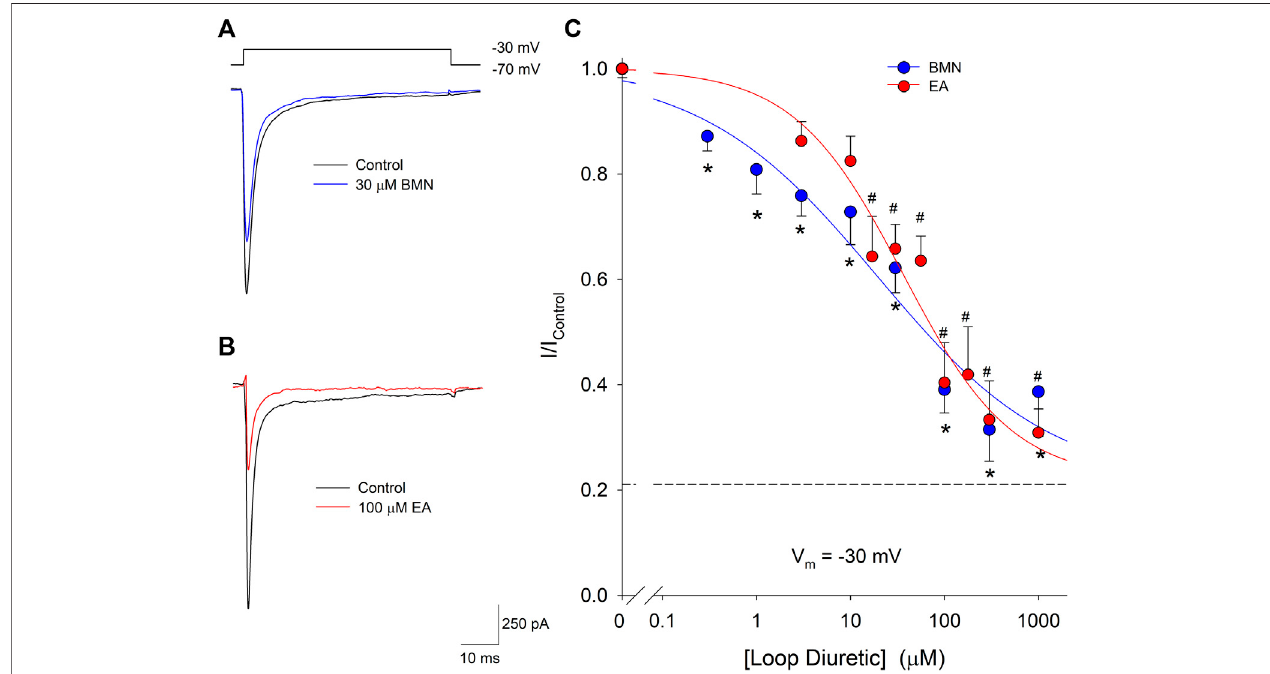
FIGURE 6 | Bumetanide and ethacrynic acid inhibit voltage-gated sodium channels in a dose-dependent manner. (A) , Representative traces of whole-cell VGSC currentsrecordedfromasingleneuroninresponseto50msecstepsfromaholdingpotentialof − 70 mVto − 30 mVintheabsence(Control,blacktrace)andpresenceof 30 μ MBumetanide(30 μ MBMN,bluetrace). (B) ,Representativetracesofwhole-cellVGSCcurrentsrecordedfromasingleneuroninresponseto50 msecstepsfroma holding potential of − 70 mV to − 30 mV in the absence (Control, black trace) and presence of 100 μ M ethacrynic acid (100 μ M EA, red trace). (C) , Concentration- response relationship of relative peak inward VGSC currents (mean ± SEM) elicited by voltage steps from − 70 to − 30 mV. Currents were normalized to control peak currentsmeasuredintheabsenceofbumetanideorethacrynicacid.Datapoints(bumetanidebluecircles;ethacrynicacidredcircles)werebest fi t(bumetanideblueline, ethacrynicacidredline)toasingle-siteLangmuir-Hillequationwithanasymptoticminimum(dashedline). n > 15forallbumetanidedatapointsandn > 6forallethacrynic acid data points. Asterisks and pound symbols denote signi fi cant difference from Control for BMN and EA, respectively ( p < 0.05). Neurons for these experiments were electrically accessed using the conventional (dialyzing) whole-cell patch clamp recording con fi